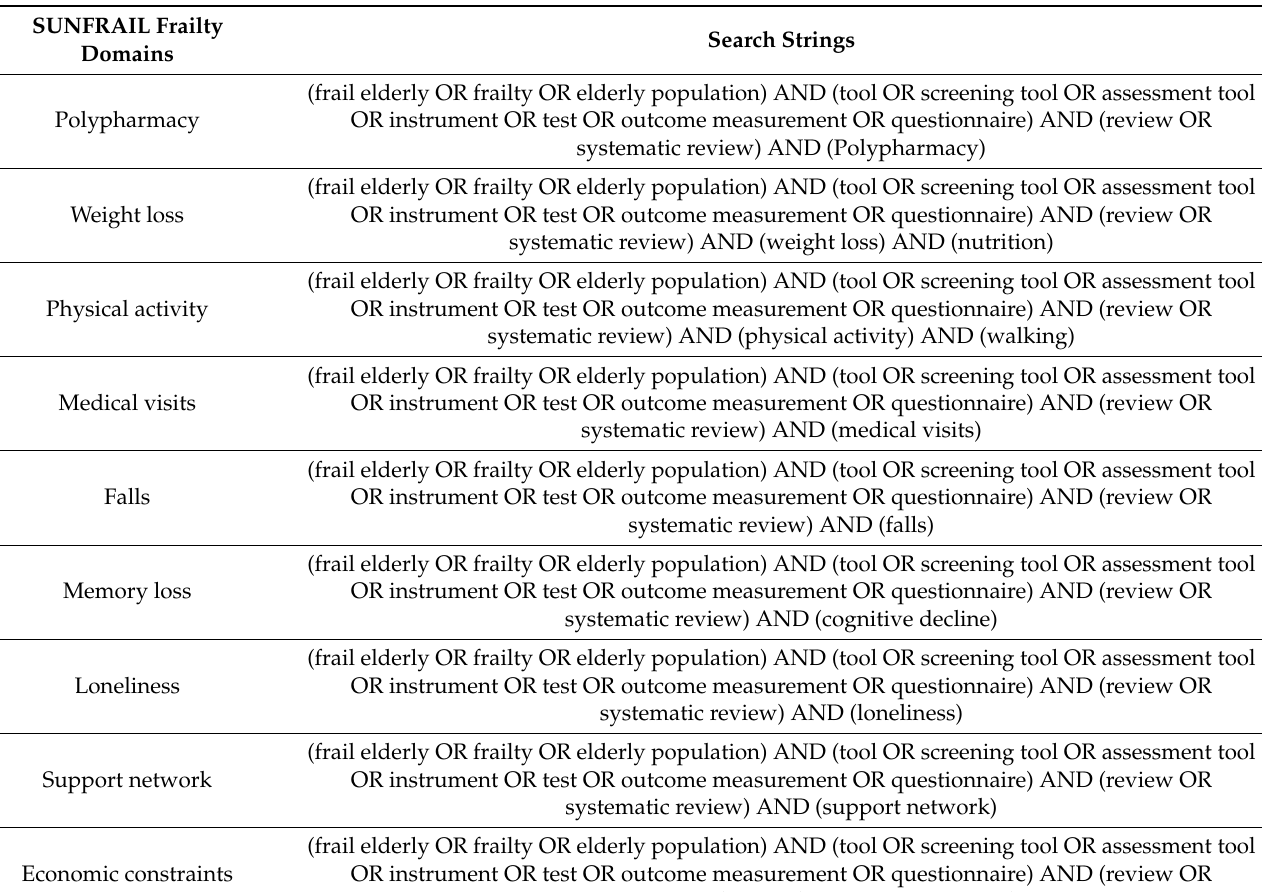
Table 1. Search strings based on the SUNFRAIL’s frailty